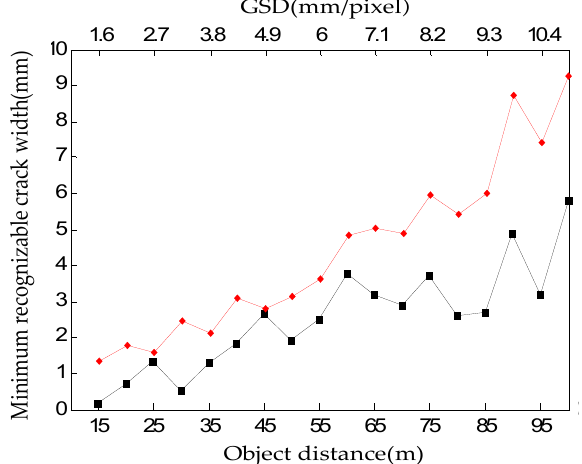
Figure 19. Graph illustrated by calculating the minimum recognizable crack width depending on the image acquisition distance under the assumption that the case where Weber contrast becomes 0.1 is the minimum recognizable crack width.